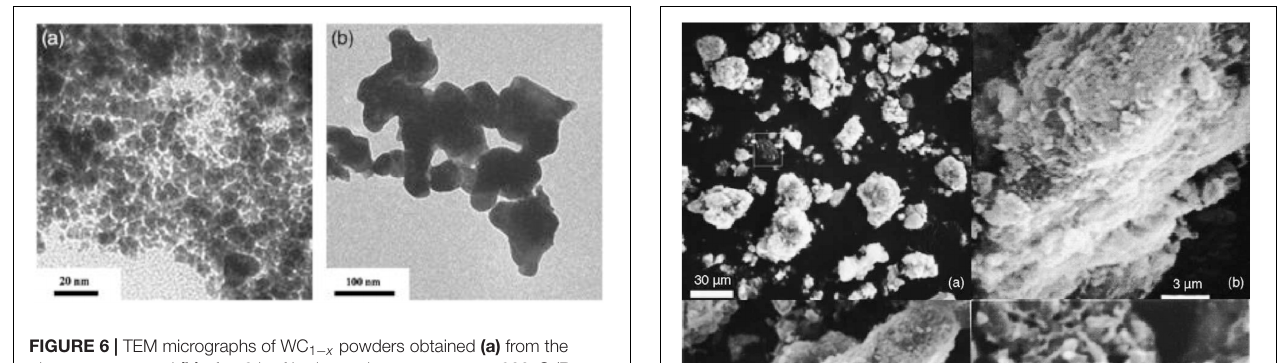
FIGURE 6 | TEM micrographs of WC 1 − x powders obtained (a) from the plasma reactor and (b) after 3 h of hydrogen heat treatment at 900 ◦ C (Ryu et al., 2009) [Figure 8 of Ryu et al. (2009), Copyright The American Ceramic Society].